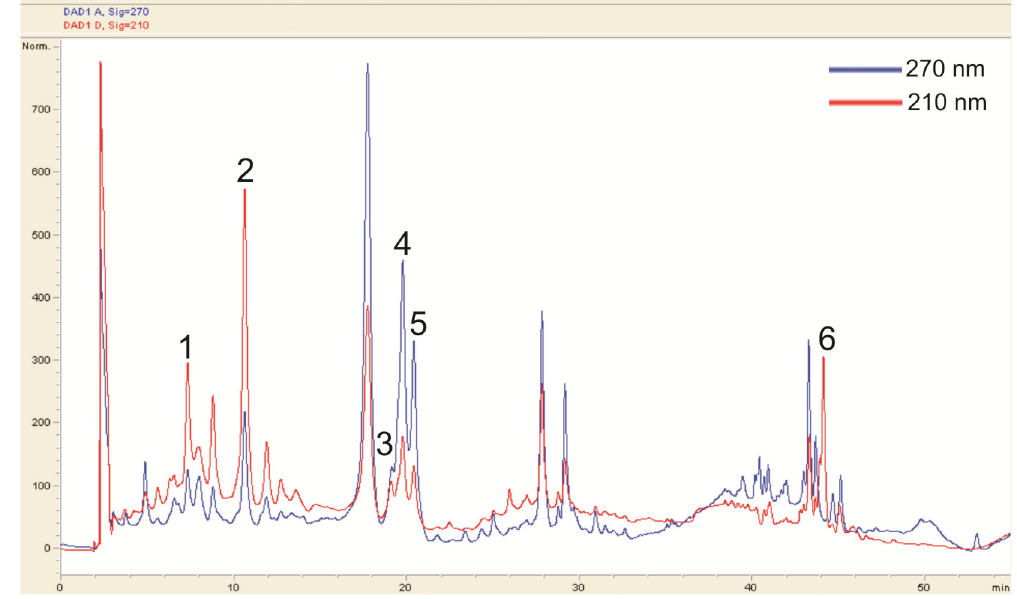
Figure 2. HPLC fingerprint of the methanol extract of the young sterile